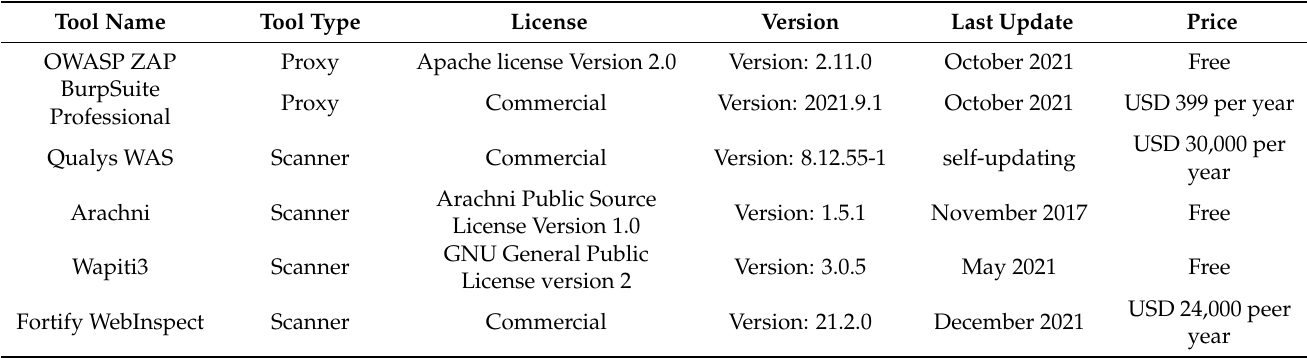
Table 1. Coverage percentage for non-commercial